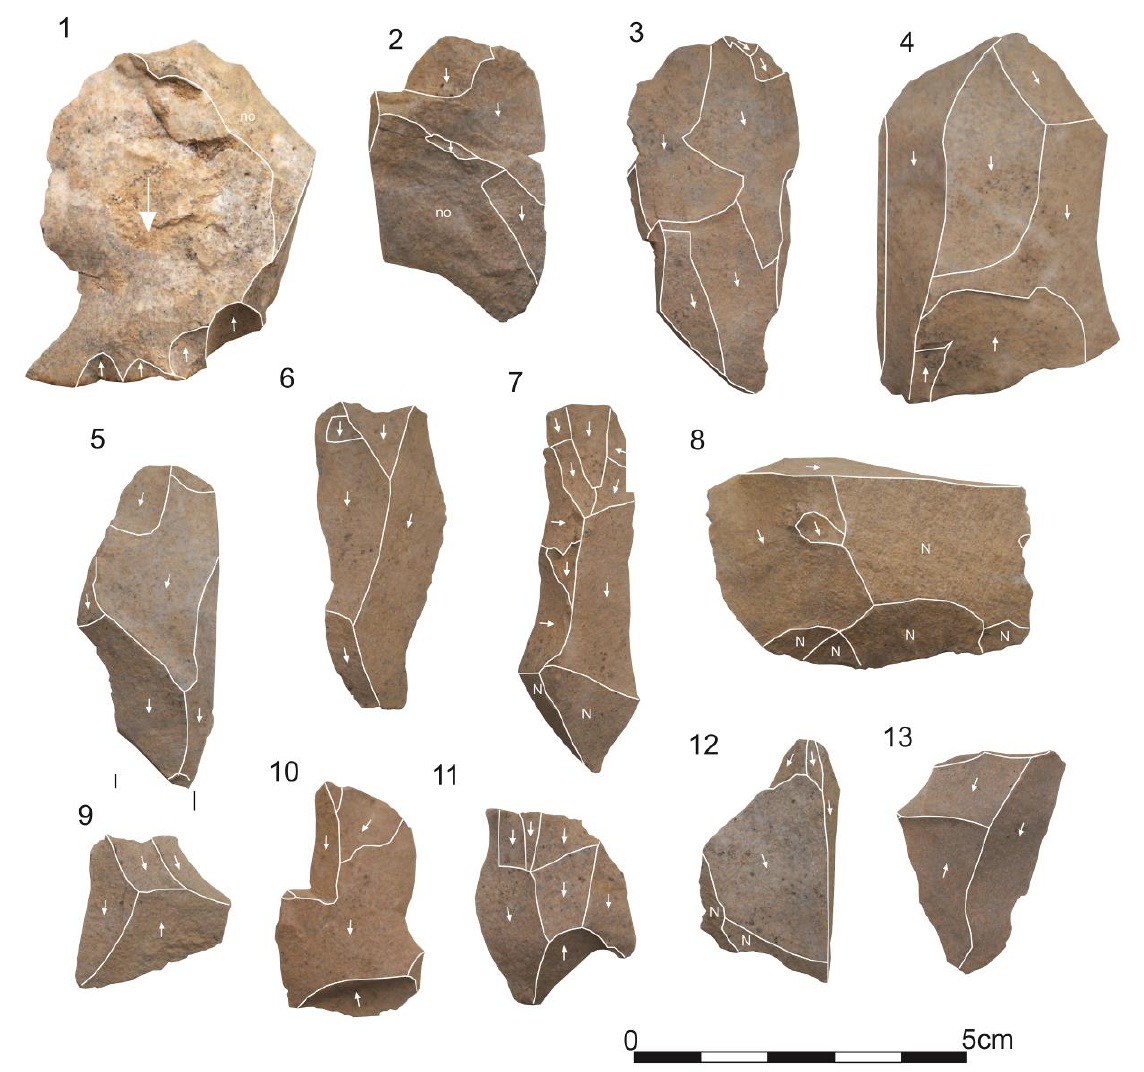
Figure 4. Quartzite artefacts from Lubrza, site 10 (photo by. A.